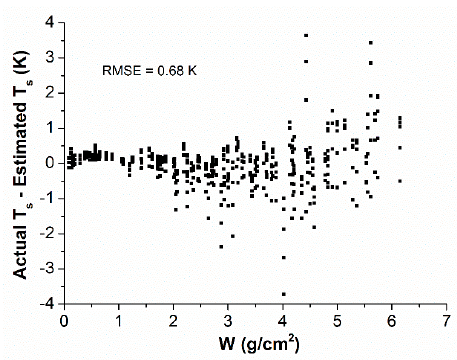
Figure 6. The residual yielded by Equation (1) for a black body. Here, W is the water vapour content.